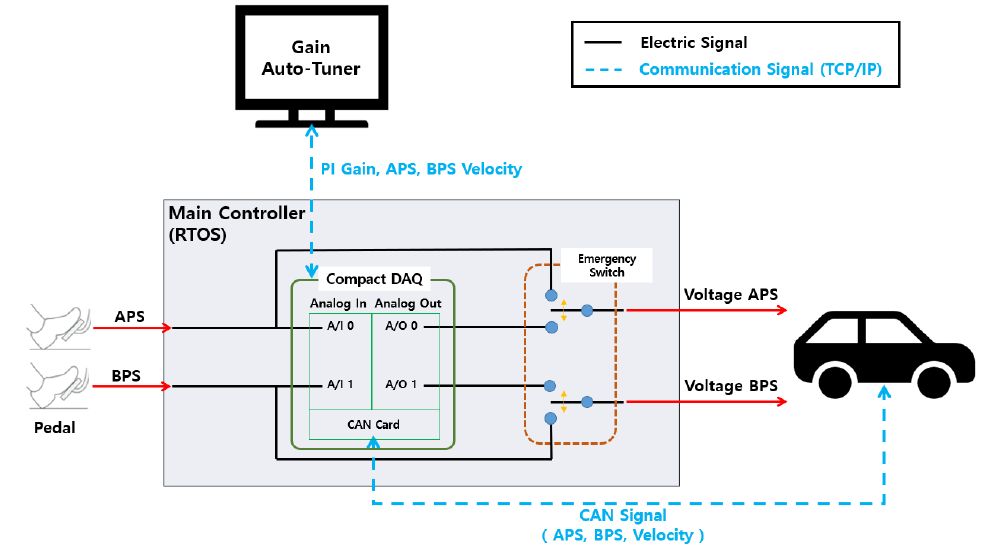
Figure 7. Simple Robotic Driver System (SimRoDS).